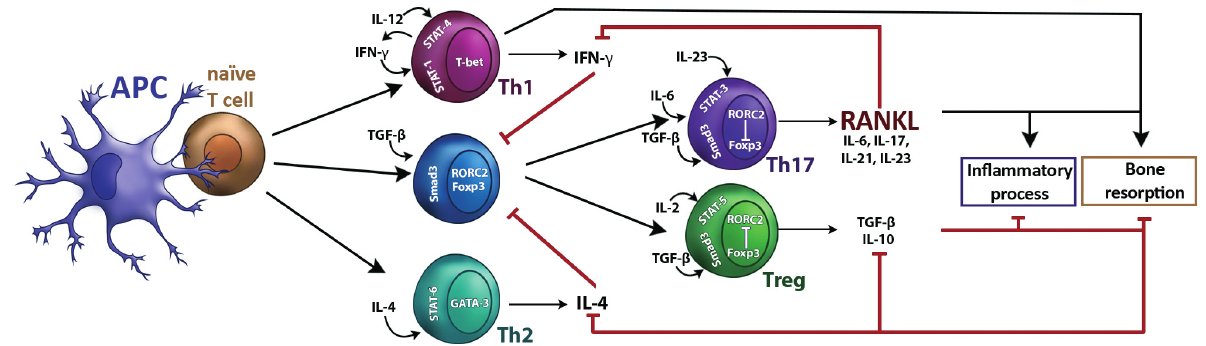
Figure 5- Osteoclastogenesis and bone resorption induction through synthesizing interleukin-17 and